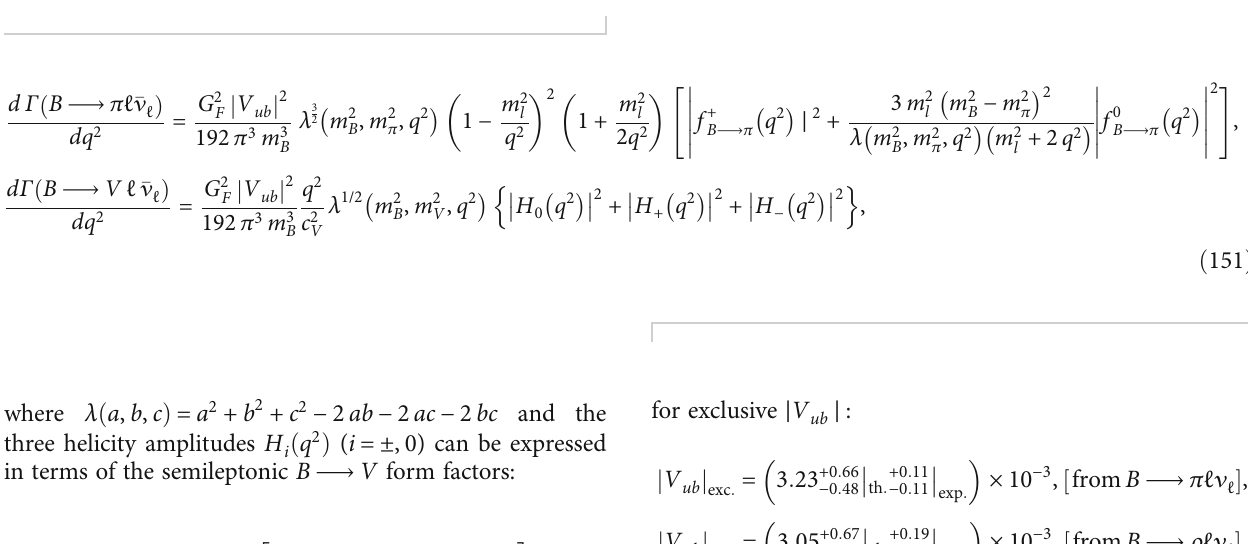
with the dominant 1, π